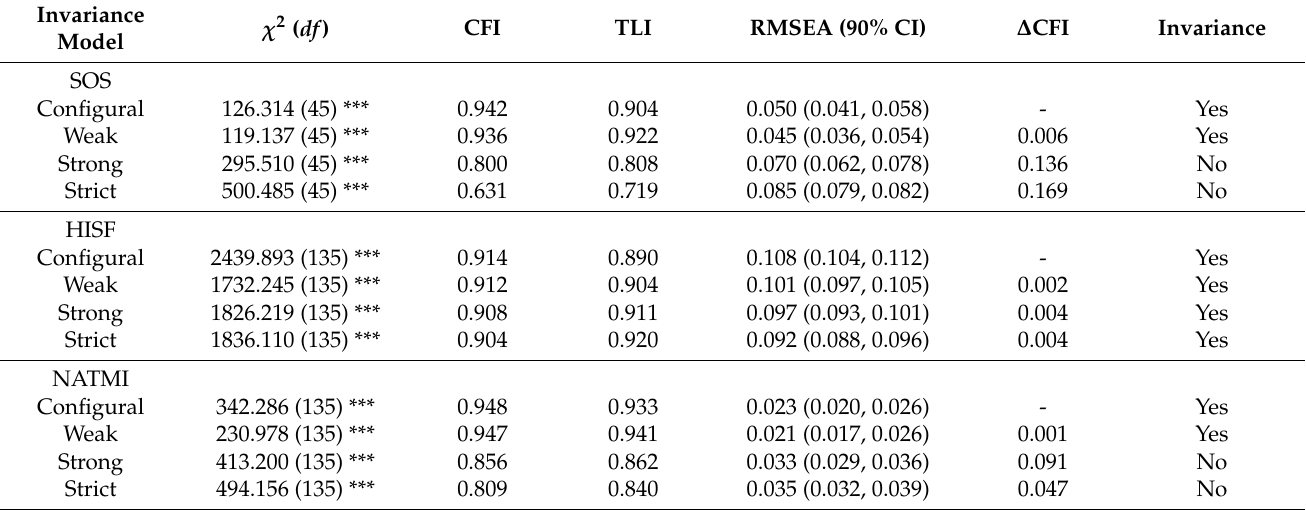
Table 4. Measurement invariance across sexual orientation for SOS, HISF, and